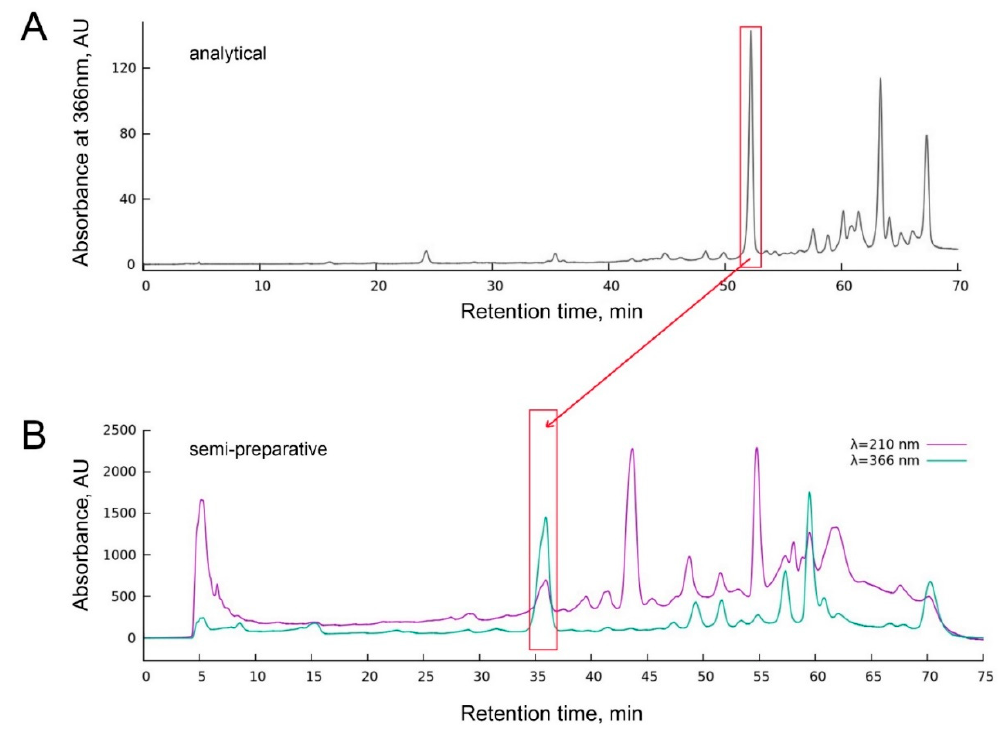
Figure 1. Analytical ( A ) and semi-preparative ( B ) chromatography of the butanol fraction of the EtOH extract of O. sarsii , absorption intensity at the wavelength of 366 nm ( A ) and 210 nm/366 nm ( B ). The major peak at the retention time of 52 min ( A ) and 35 min ( B ) corresponds to ETPA (chlorin) from our previous study [10] . Chromatograms from non-fasted ophiuras are shown in both panels; samples from the fasted ophiuras show identical chromatograms.